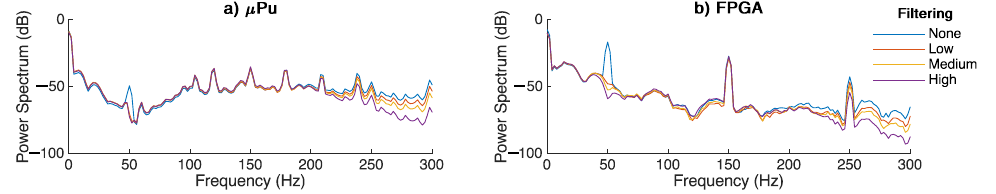
Figure 4. PSD of a generated neonate biosignal for ( a ) μ PU system, ( b ) FPGA system.